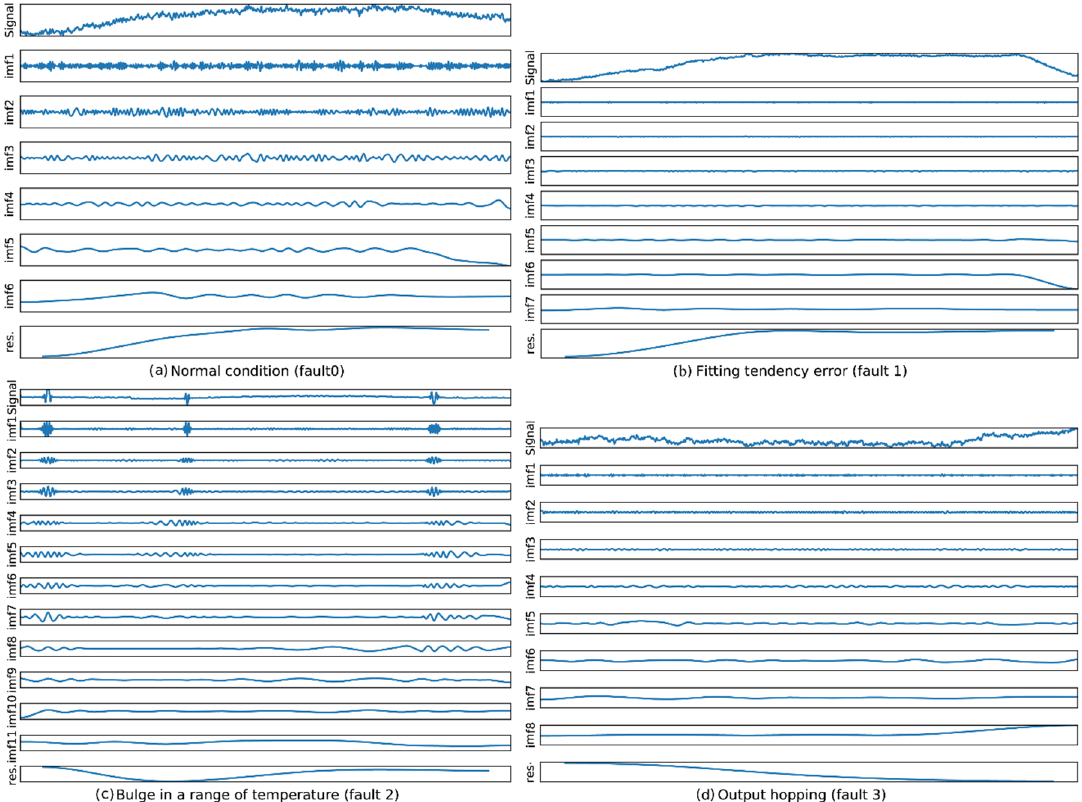
Figure 7. IMFs of each inertial sensor fault. ( a ) the IMFs in case of normal condition; ( b ) the IMFs in case of fault 1 occurs; ( c ) the IMFs in case of fault 2 occurs; ( d ) the IMFs in case of fault 3 occurs.